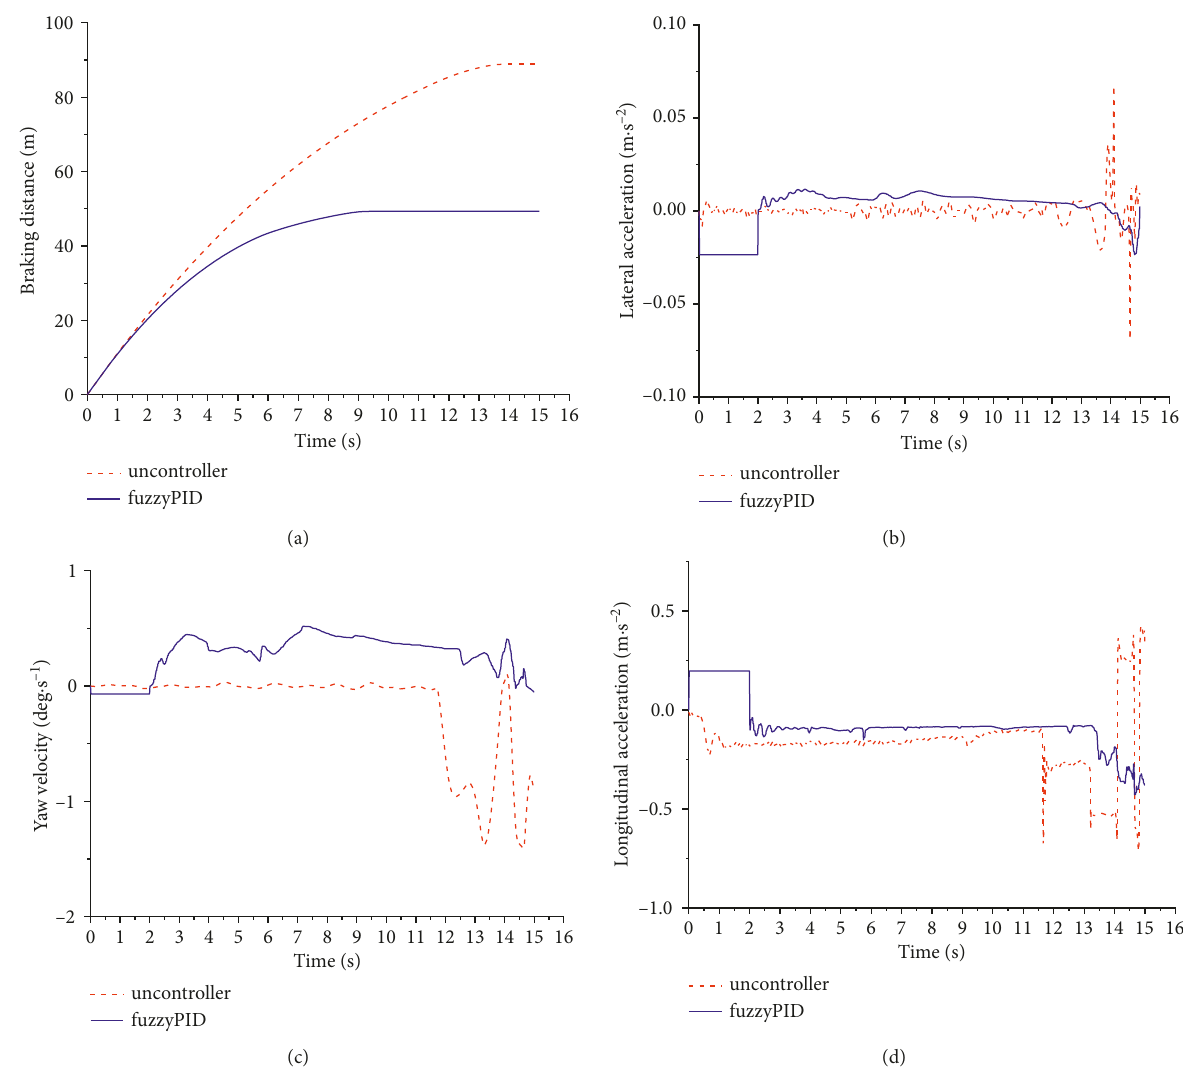
Figure 28: HIL test diagram under long downhill condition when u � 0.4. (a) Braking distance. (b) Lateral acceleration. (c) Yaw velocity. (d) Longitudinal acceleration.